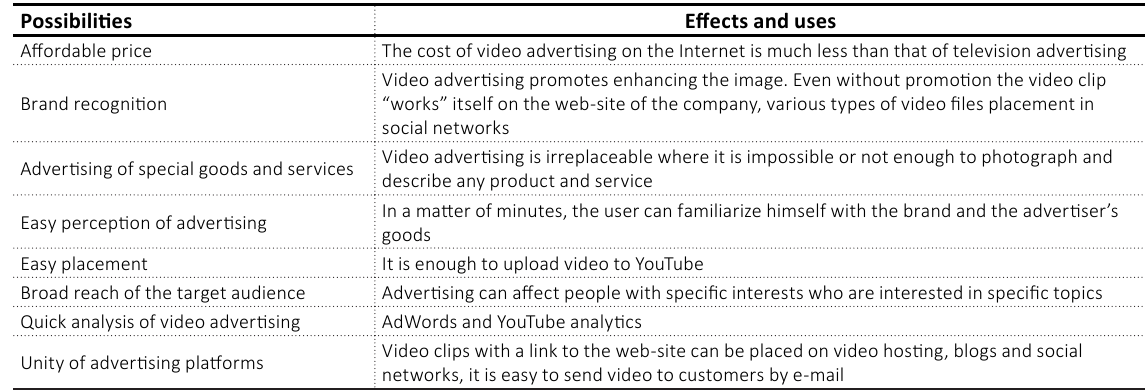
Table 2. Benefits of video advertising on the YouTube